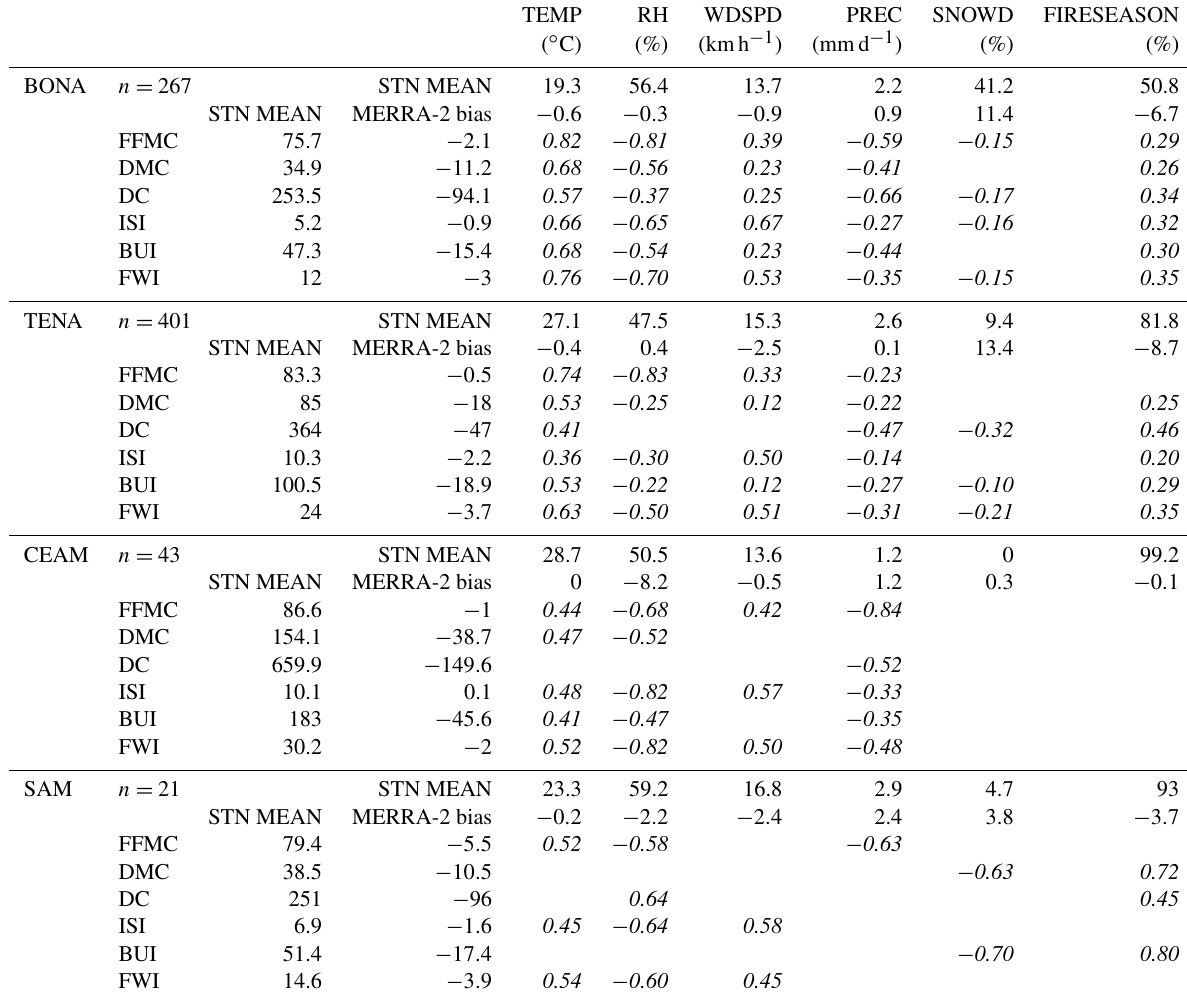
Table 3. Same as Table 2 but for the BONA, TENA, CEAM and SAM